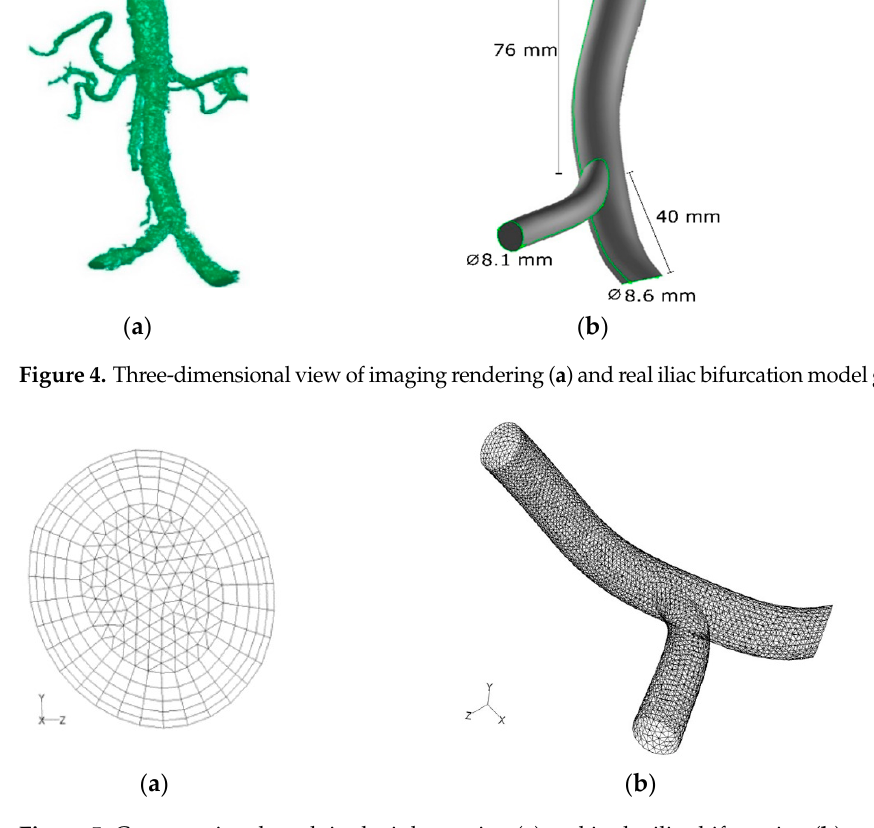
Figure 5. Computational mesh in the inlet section ( a ) and in the iliac bifurcation ( b ).